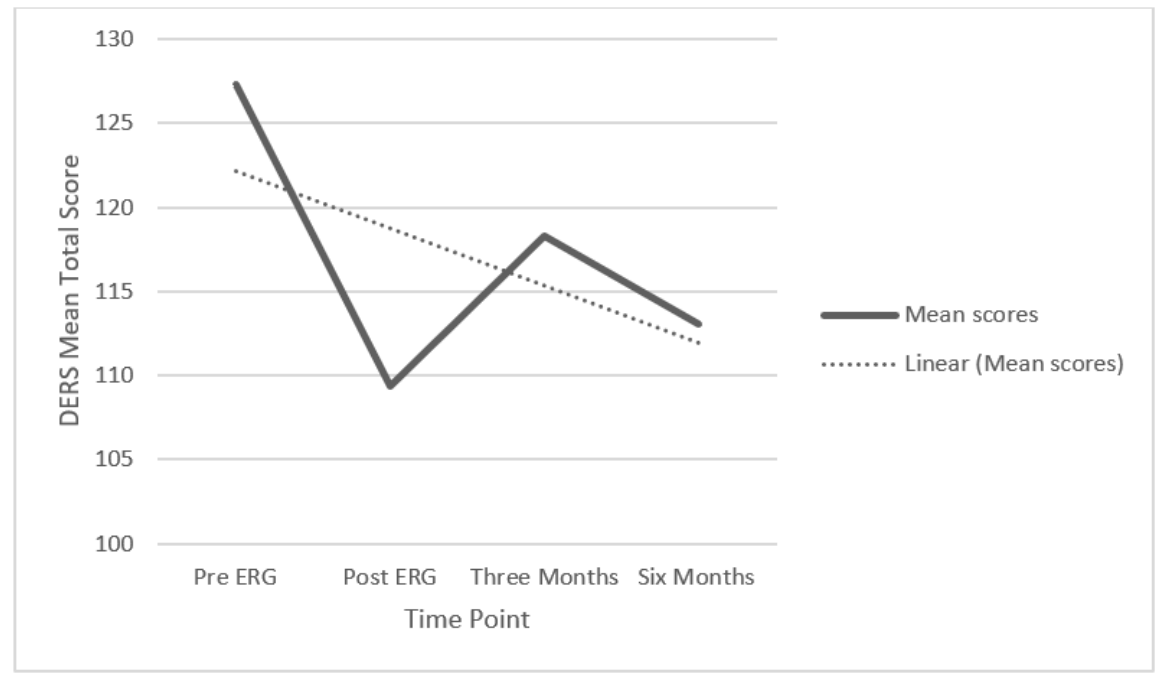
Figure 2. DERS Mean Total Score over time with fitted trendline.